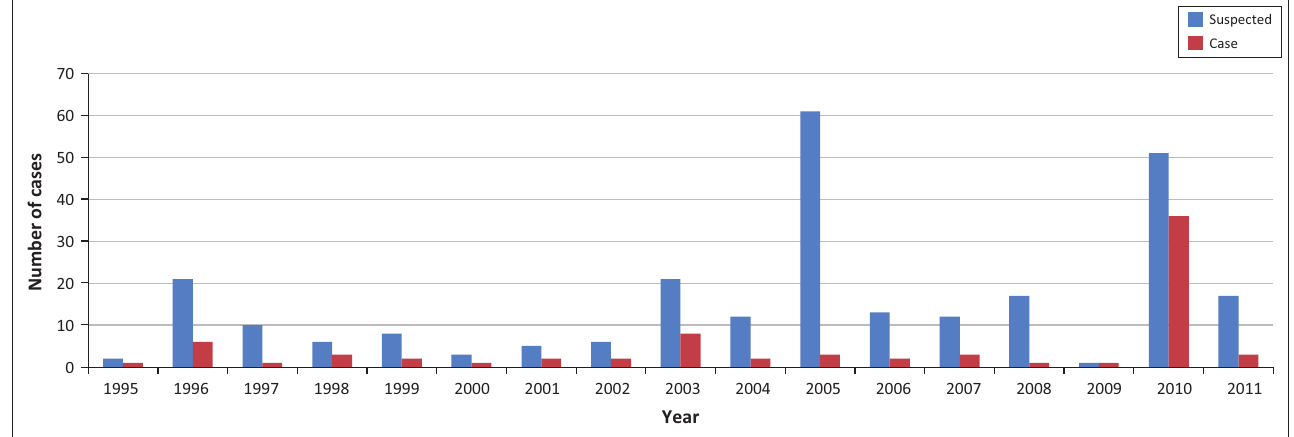
FIGURE 2: Suspected cases compared to laboratory-confirmed cases, Rwanda, 1995–2011.